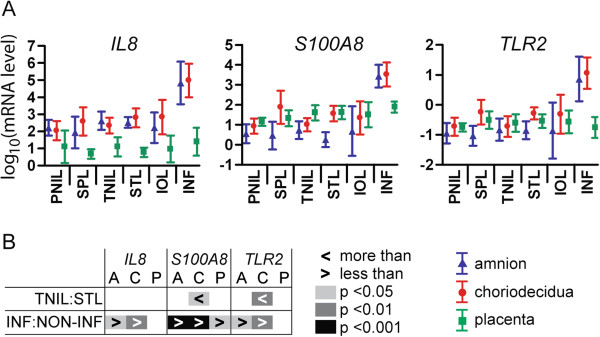
Expression of inflammatory genes in pregnant human uterine tissues. (A) Relative levels of mRNA by ΔΔCt method following qPCR, log10-transformed, shown as mean ± SD. PNIL, preterm not-in-labour; SPL, spontaneous preterm labour; TNIL, term not-in-labour; STL, spontaneous term labour; IOL, induction of labour; INF, inflammation. Numbers of samples: PNIL = 4; SPL = 4; TNIL = 6; STL = 5; IOL = 5; INF = 4. (B) Statistical comparisons of gene expression. No significant relationships were observed with gestational age in not-in-labour or spontaneous labour groups, between preterm and term not-in-labour or with duration of labour, so these comparisons are not shown. Comparisons of gene expression in the presence and absence of labour at term and of inflammation were tested by Student’s t-tests. Level of significance and direction of differential comparison are indicated. A, amnion; C, choriodecidua; P, placenta.